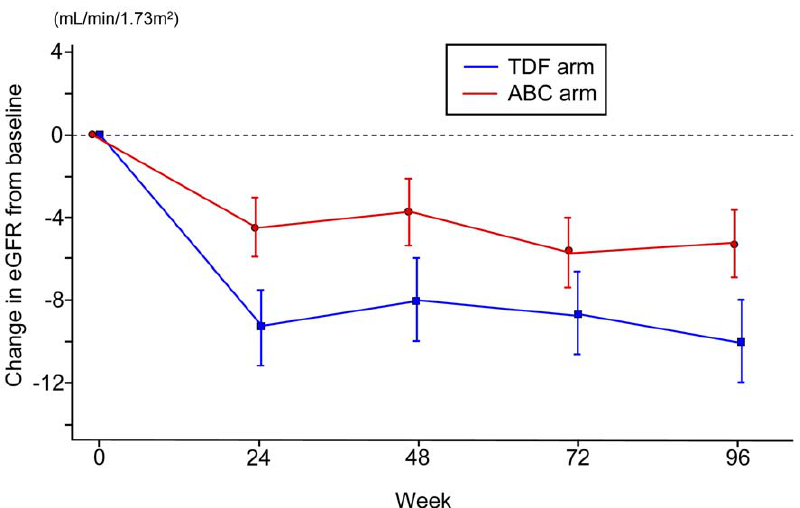
Figure 2. Changes in eGFR in patients treated with TDF or ABC between baseline and 96 weeks. The fall in eGFR was significantly greater in the TDF group than the ABC group (p=0.003). Data are adjusted mean 6 95% confidence interval. eGFR: estimated glomerular filtration rate, TDF: tenofovir, ABC: abacavir.